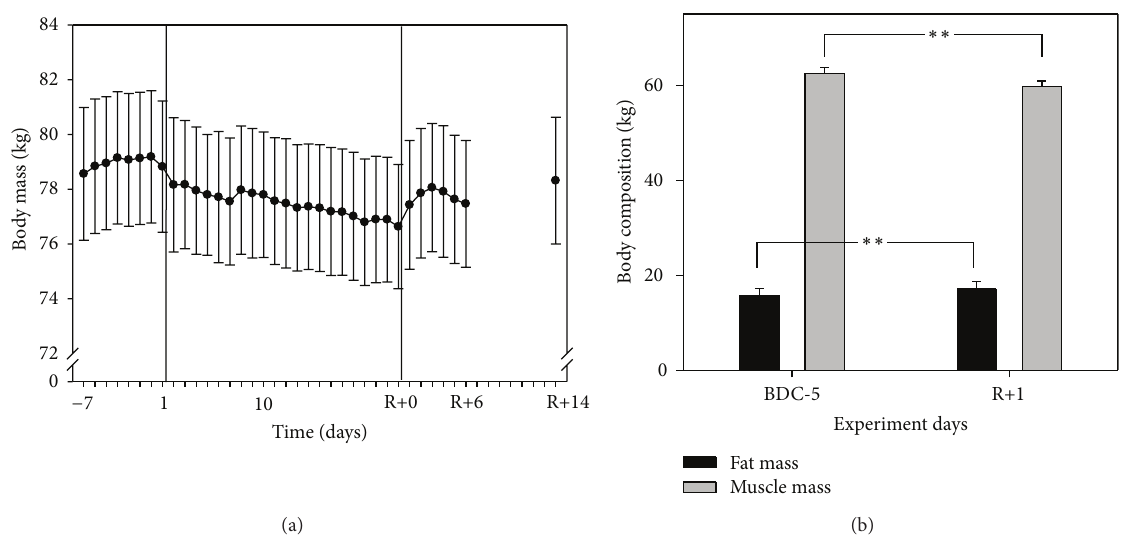
Figure 3: (a) Mean values and SEM of daily body mass data during the entire in-house phase and on day R+14. The vertical lines after day 1 and day R+0 represent the period of HDT bed rest. Body mass decreased significantly during the bed-rest period ( 𝑃 < 0.001 ). (b) Mean values and SD of fat and muscle mass analyzed by DXA 5 days before HDT bed rest and on the first recovery day. ∗∗ 𝑃 < 0.01